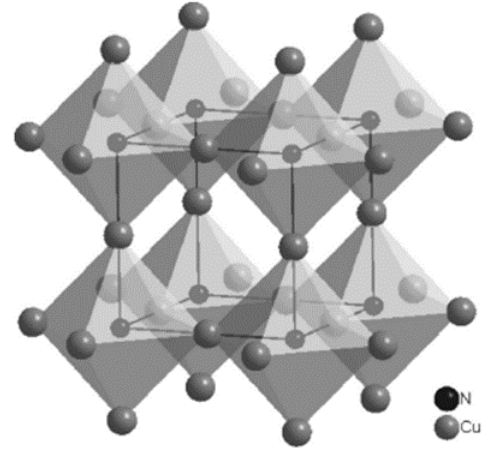
Figure 1. The cubic anti-ReO 3 crystal structure of Cu 3 N [4].